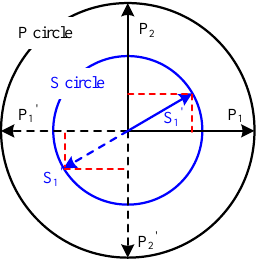
Figure 7. Phasor diagram of capacitive sub-phases